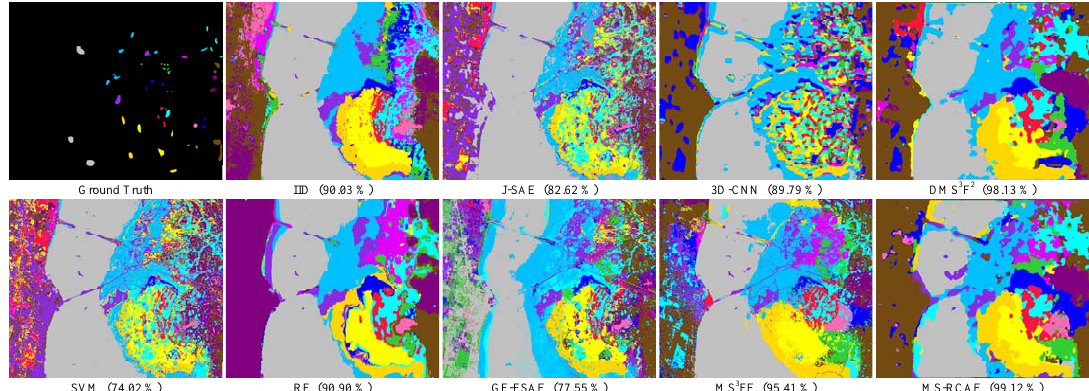
Figure 11. Classification maps of the Salinas dataset obtained by different methods (AA).